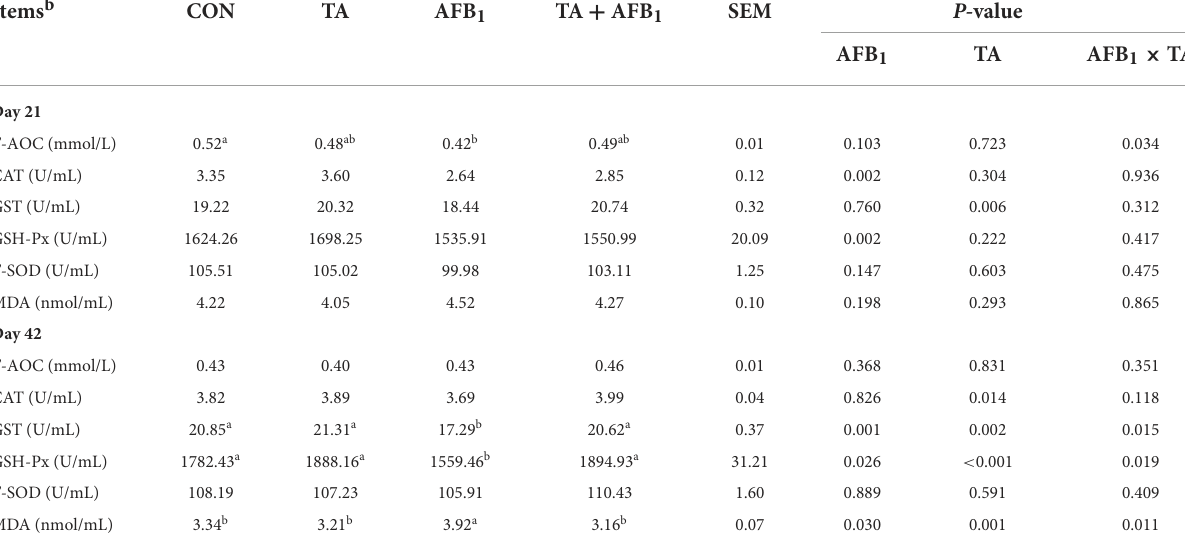
TABLE 5 Effects of tannic acid on plasma antioxidant capacity of broilers challenged with AFB a 1